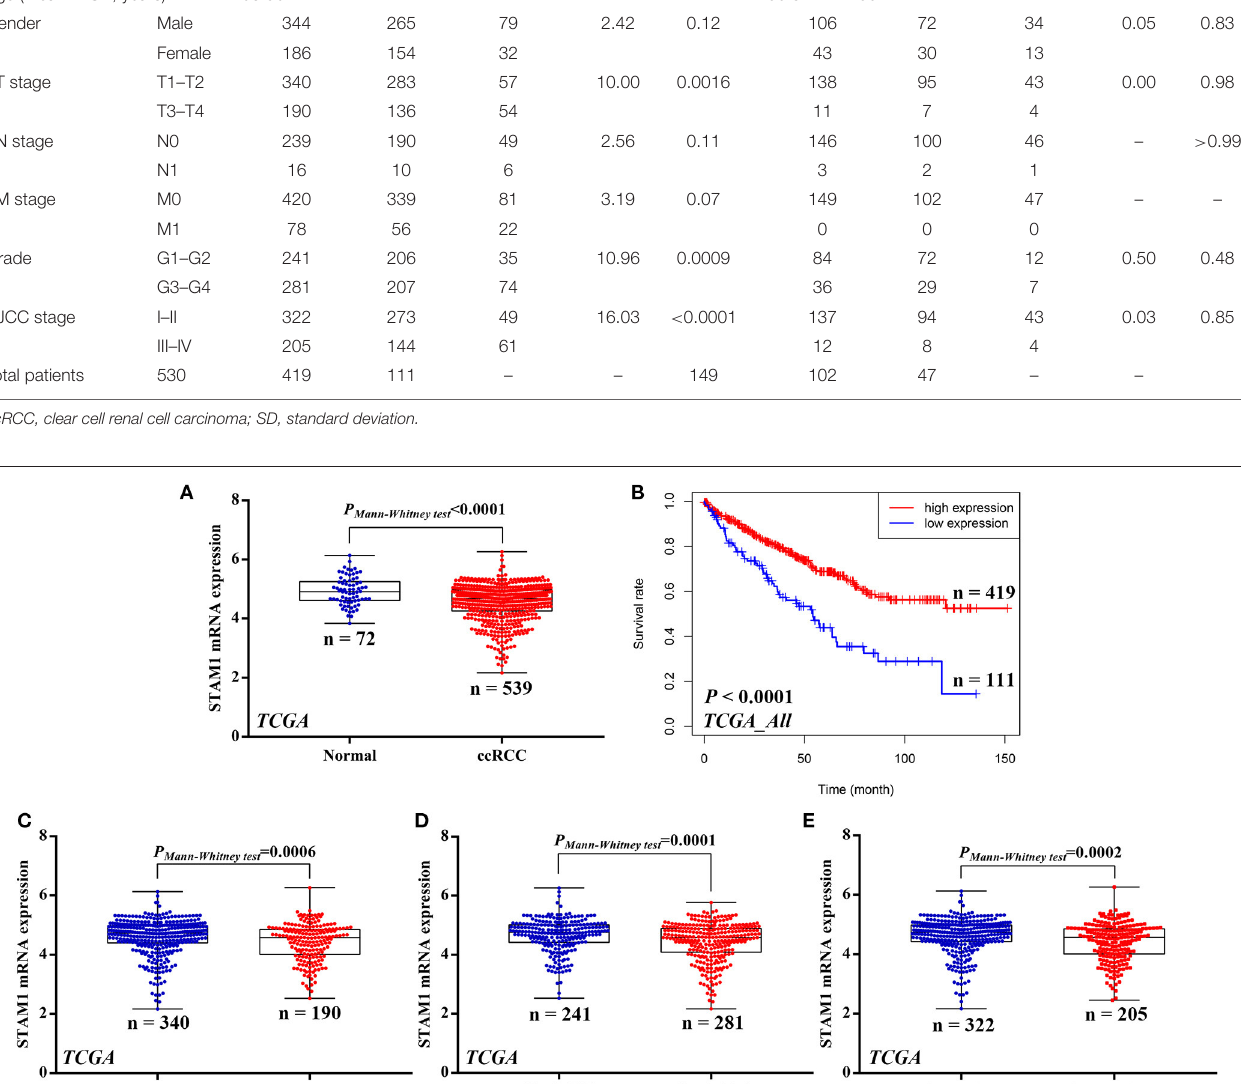
(HR = 23.47, 95% CI: 1.07–515.14, P = 0.045), grade (HR = 3.02, 95% CI: 1.08–8.42, P = 0.03), and STAM1 expression (HR = 0.12, 95% CI: 0.04–0.32, P < 0.001) were identified as independent prognostic factors after a multivariate